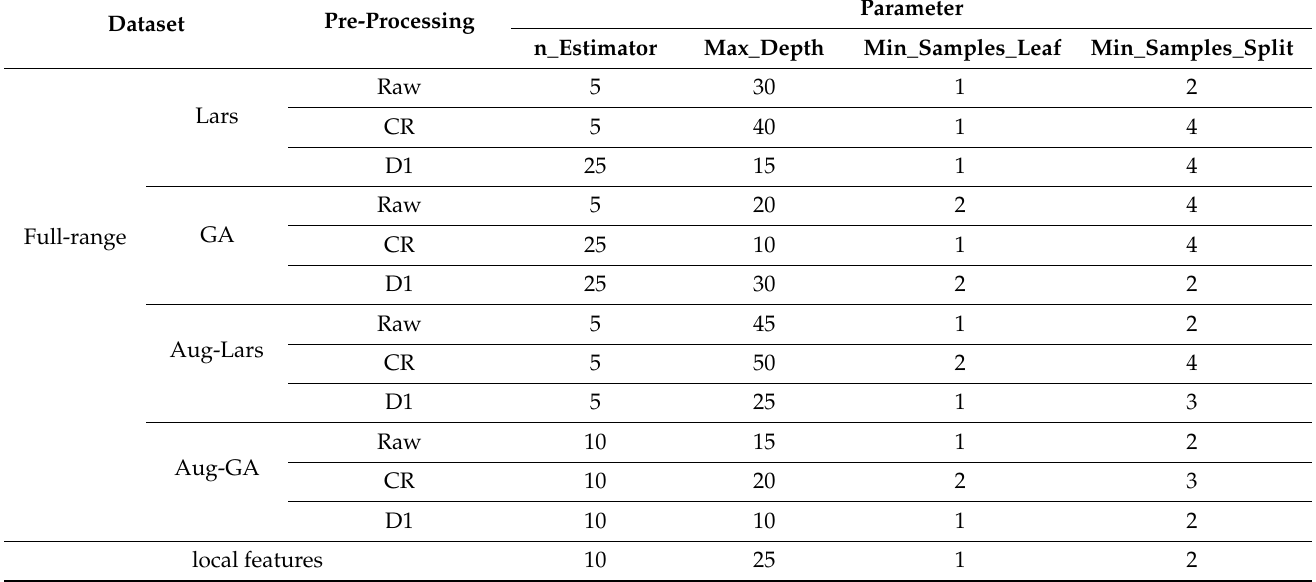
Table 2. Identify the model parameter